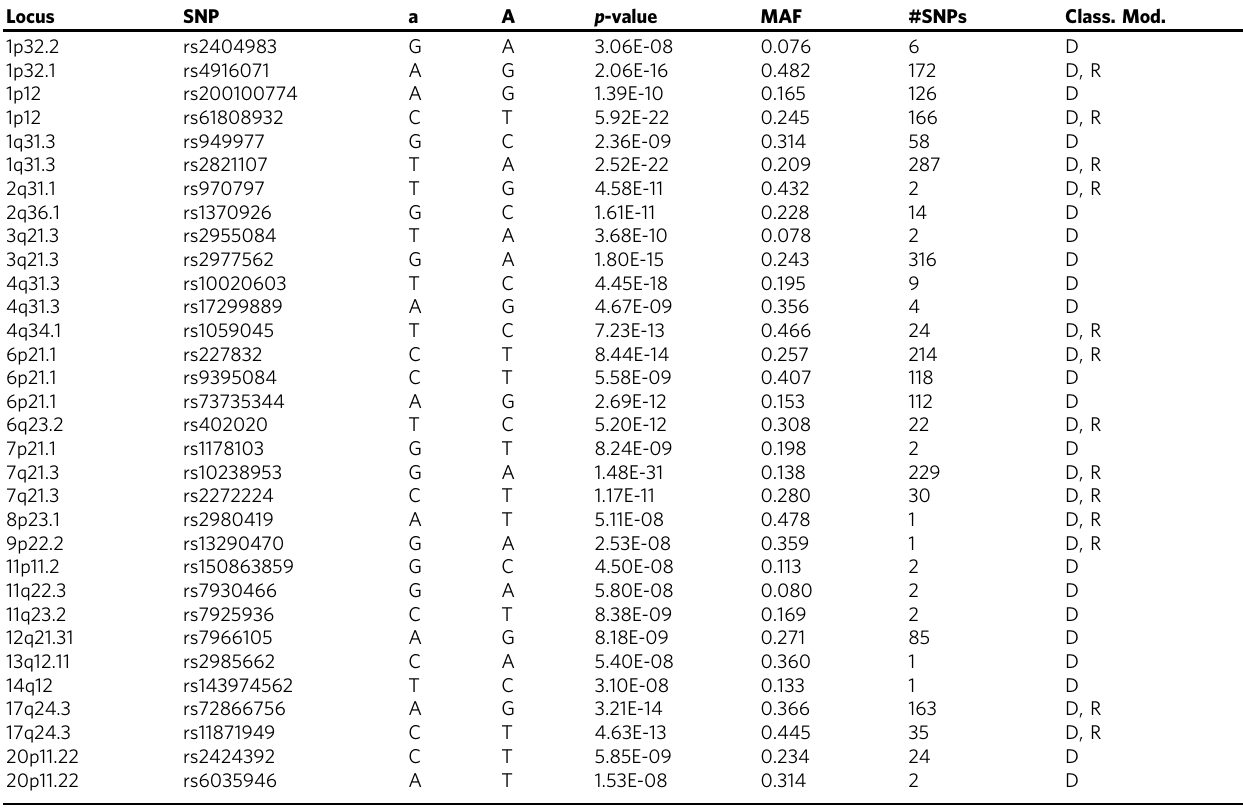
Table 1 Properties of 32 genetic loci identi fi ed in a GWAS on the EURO training data set Locus SNP a A p -value MAF #SNPs Class. Mod. 1p32.2 rs2404983 G